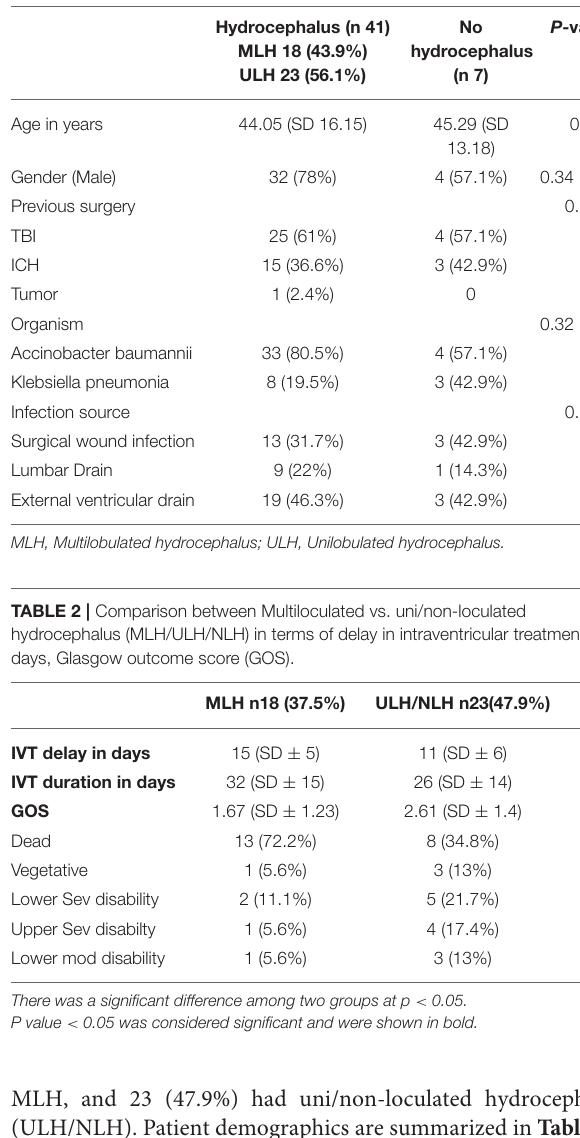
TABLE 1 | Shows the gross demographic distribution of patients with and without hydrocephalus; age, gender, previous surgery, isolated organism, and source of infection.